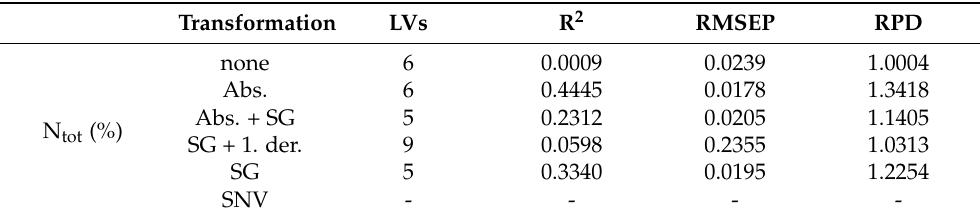
Table 5. Evaluation of developed models after resampling the spectral information for the purpose of prediction from hyperspectral